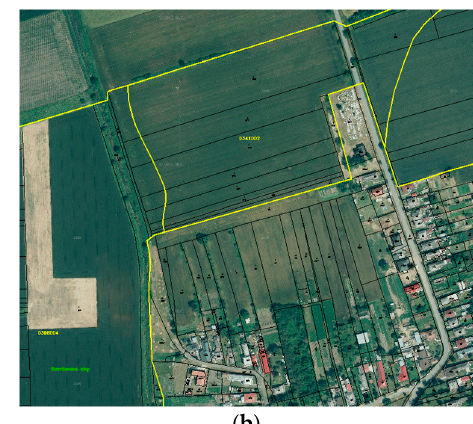
Figure 16. Verification of the EPEU code of the proposed area ( a ) slope analysis; ( b ) histogram from the slope analysis; ( c ) exposure analysis.